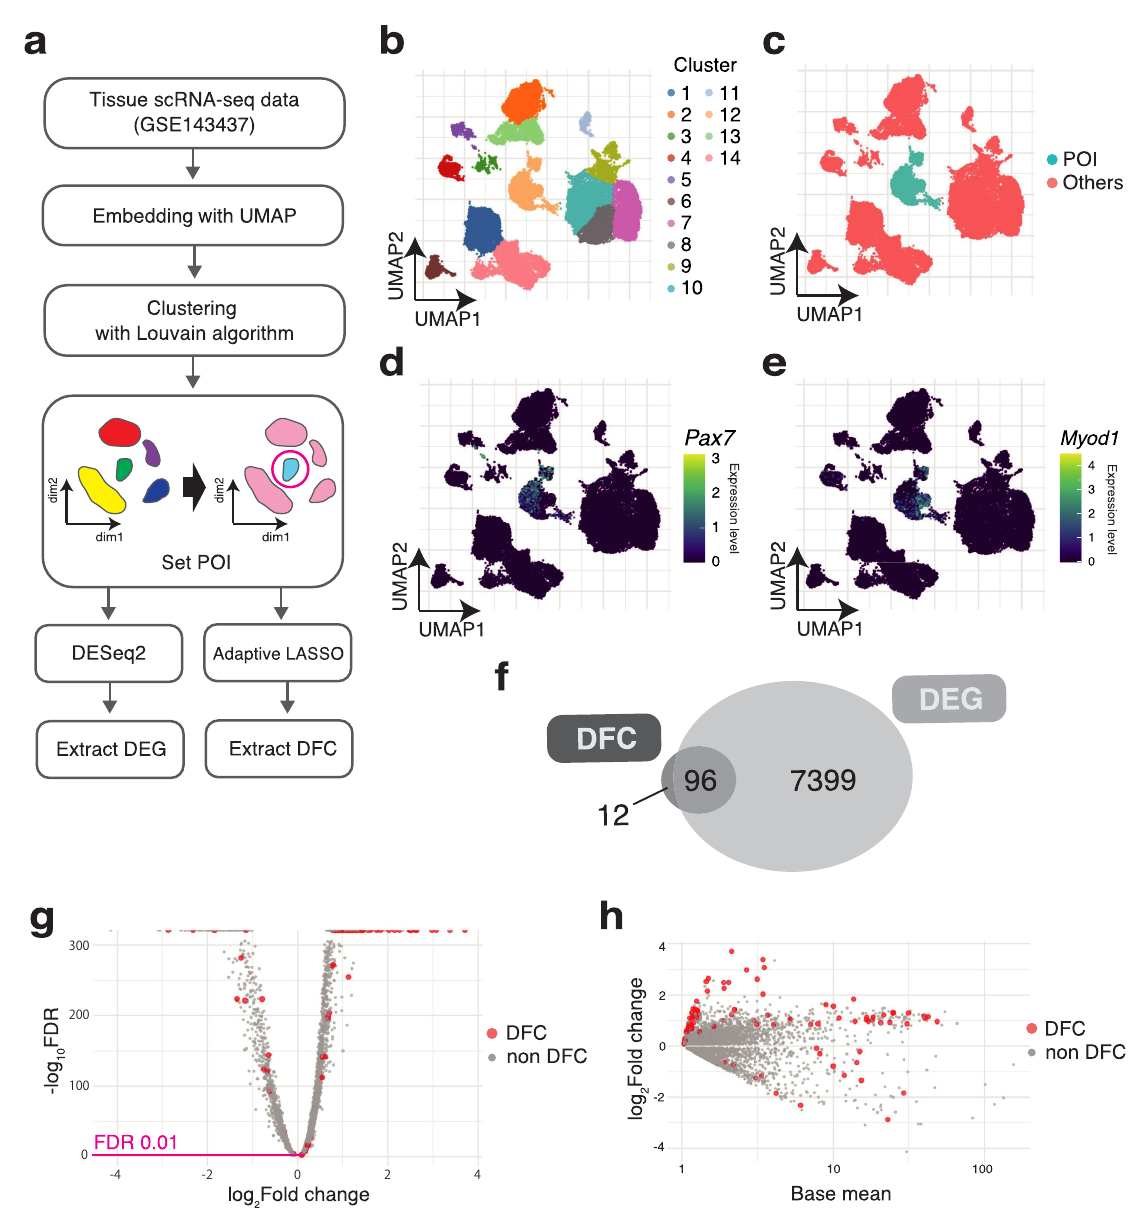
Fig 2. Smaller gene set of DFC was selected by a unique selection criterion. (a) Procedure of DEG and DFC extraction from scRNA-seq data. (b–e) The determined POI is compared with all other cell clusters in the muscle tissue. Embedding the scRNA-seq data into two- dimensional space with UMAP. (b) The clusters determined by the Louvain algorithm. The 12th cluster corresponds to the cluster of muscle stem cells and their progenitors. (c) The 12th cluster is set as the POI, and the other clusters are assigned as the control group, “Others.” (d, e) Single-cell expression levels for Pax7 and Myod1 . (f) Some of the DEGs are selected as DFC. Venn diagram indicating the overlap of DEGs and DFC. (g) Genes in DFC not selected by the DEGs’ criteria. Volcano plot of DEGs and (h) MA plot of DEGs. ten times for averaging the effect of subsampling and cross-validation. For the other option to detect DEGs, limma [5] is known to be effective for DE analysis in single-cell RNA-seq data [10], the large number of genes was extracted as in DESeq2. For the DFC set extracted by each method, we created UpSet plots (S1C Fig) and analyzed the association between genes using the STRING database (S1 Table). The UpSet plots show that LASSO extracted a large number